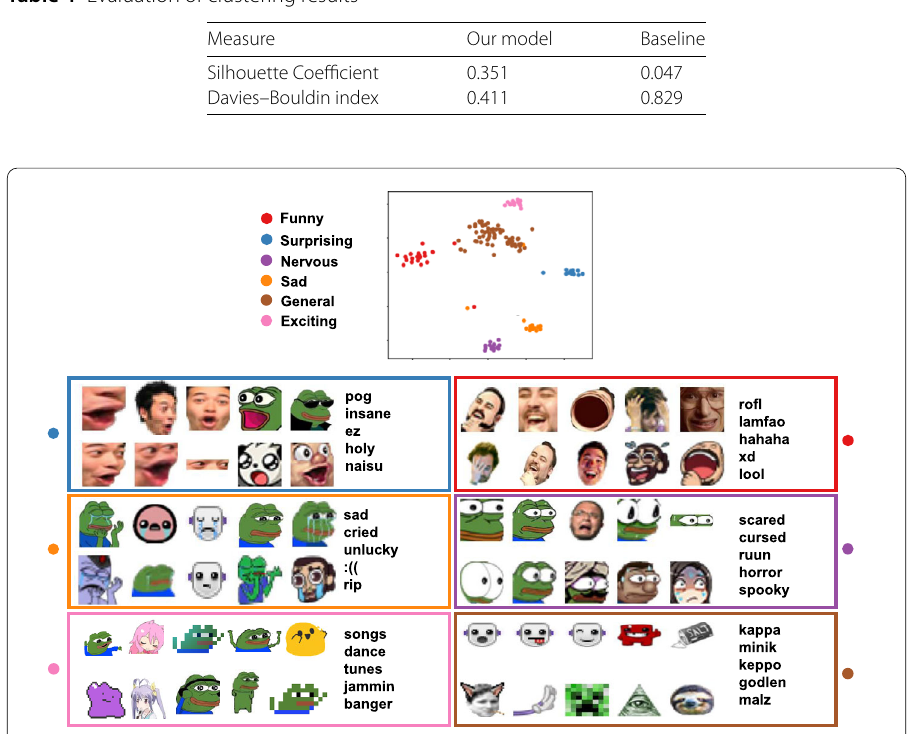
Figure 4 Example emotes and related text of each cluster. Representation of each emote embedding vectors (above) and example emotes and related text tokens (below). Representations are plotted by t-SNE and related tokens are selected by the distance between emote cluster and word vector